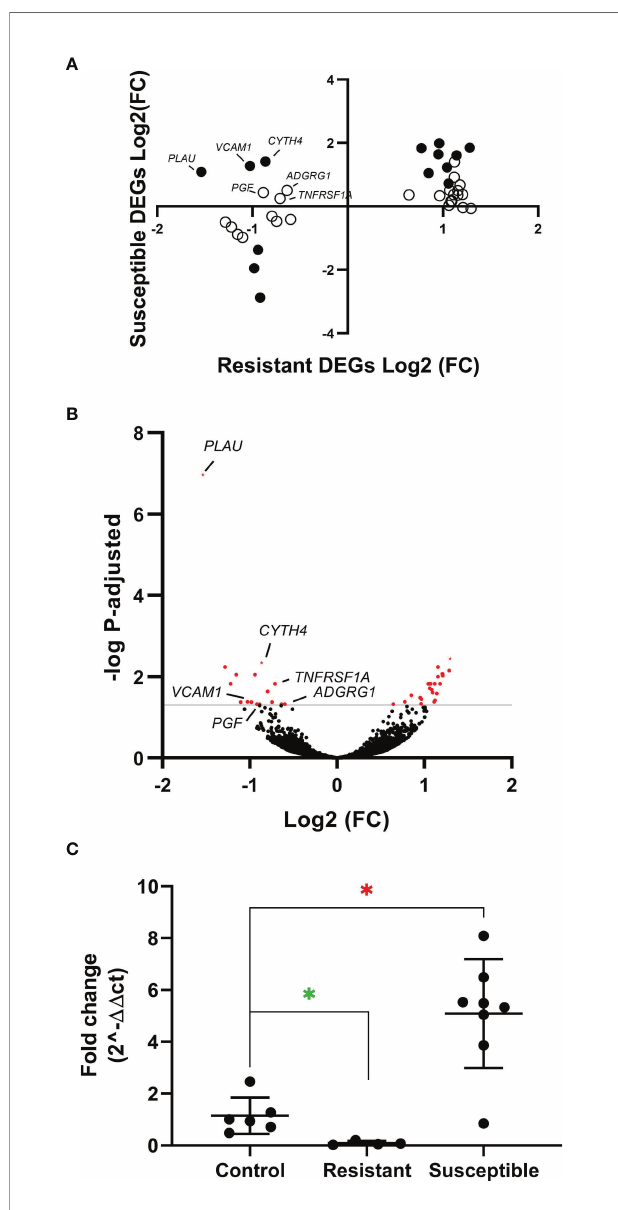
FIGURE 6 | (A) Expression pattern of the 39 resistant-speci fi c DEGs in lungs from susceptible (y-axis) and resistant (x-axis) chickens. Fold changes of the 39 genes in both groups are represented. Black dots indicate DEGs in both susceptible and resistant birds. White dots indicate DEGs only in resistant birds. (B) Volcano plot showing all genes identi fi ed by RNAseq in lungs from resistant chickens. In red are shown the 39 DEGs (BH adjusted P < 0.05). (C) Quantitative PCR of PLAU from lungs of resistant and susceptible H5N8 inoculated chickens collected at 3 dpi. Lungs from uninfected chickens were used as control. For each group the mean and standard deviation are shown. Green asterisk means signi fi cant downregulation and red asterisk means signi fi cant upregulation ( ∗ ) BH adjusted P ≤ 0.05 from Wald test p-value with